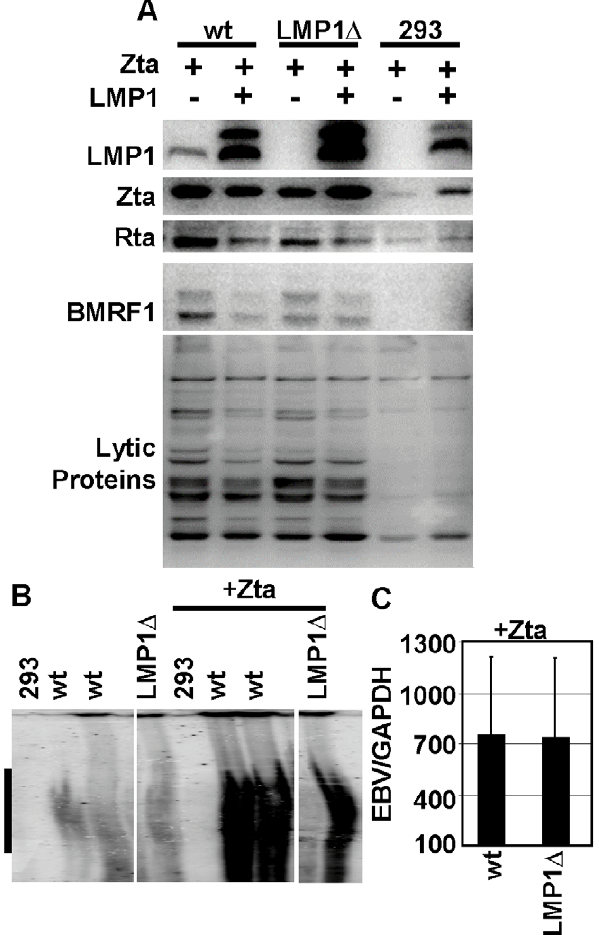
Figure 2. LMP1 D BAC replicates to wildtype levels in HEK293 cells. (A) Western blot analysis of 293 cells with the indicated BAC 4 days after the virus was induced to replicate with Zta or Zta and LMP1 expression. Rta, BMRF1 and lytic protein expression was induced to the same extent in wt and LMP1 D cells. LMP1 transcomplementation inhibited Rta expression. (B) Zta induces virus DNA replication in wt and LMP1 D HEK293 cells, Gardella gel analysis, linear genomes marked by black bar. (C) Zta-induced replication is unaffected by LMP1 deletion; .EBV (BALF5) per GAPDH copies of intracellular virus was normalized to the percentage of gp350 + cells.